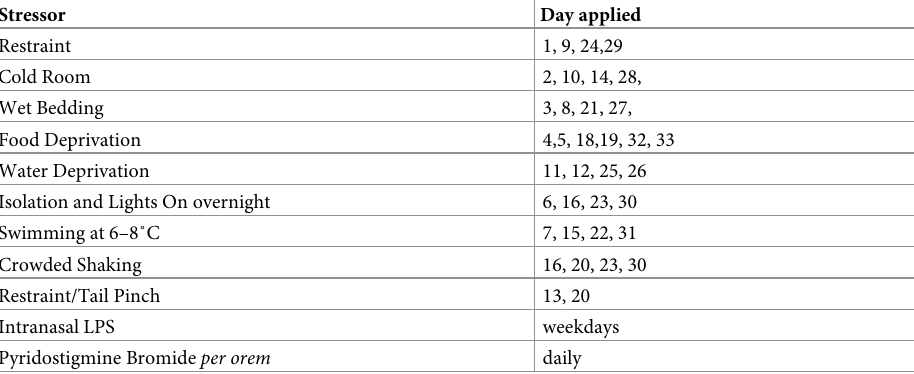
Table 1. List of stressors and day when